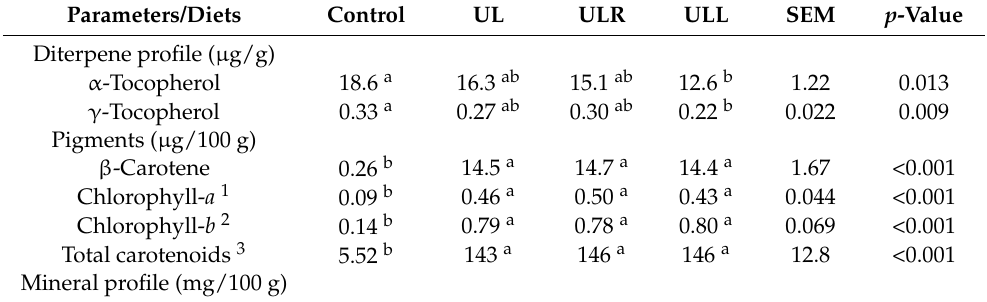
Table 4. Hepatic vitamin E, pigments and mineral contents of broilers as affected by diets ( n = 10). Parameters/Diets Control UL ULR ULL SEM p